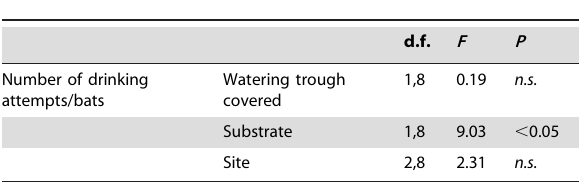
Experiment 2: Water vs. Black Perspex